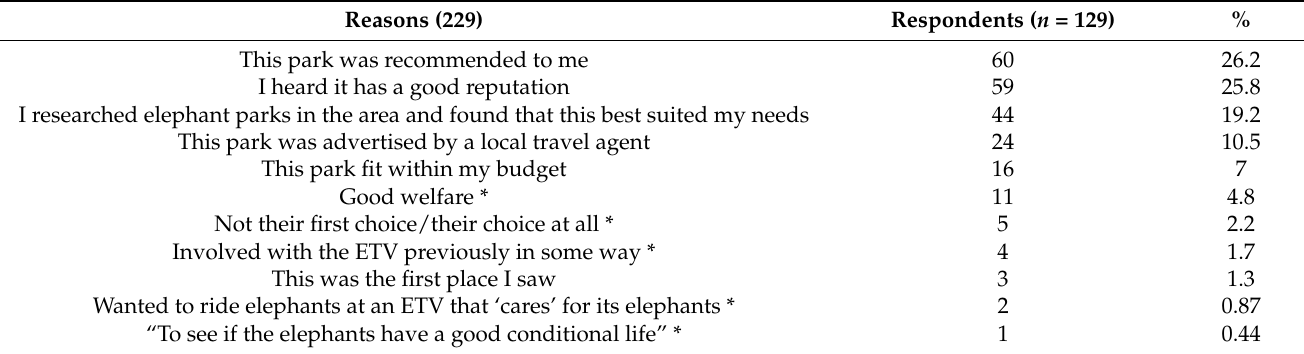
Table 1. Reasons given by respondents for choosing the ETV visited ( n = 129).